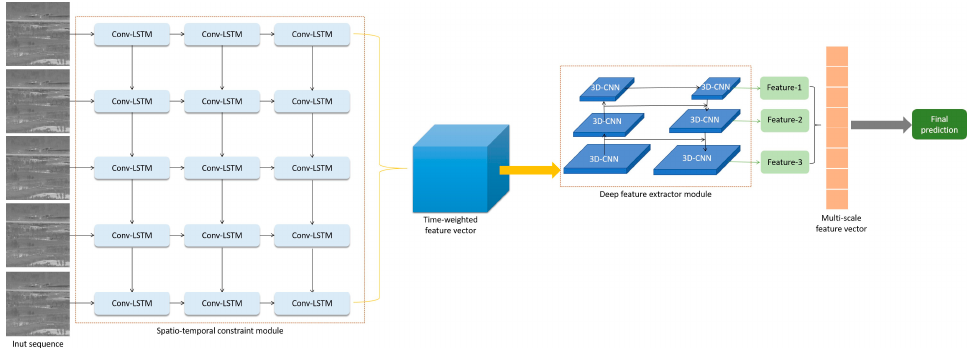
Figure 5. Overview of the proposed model.